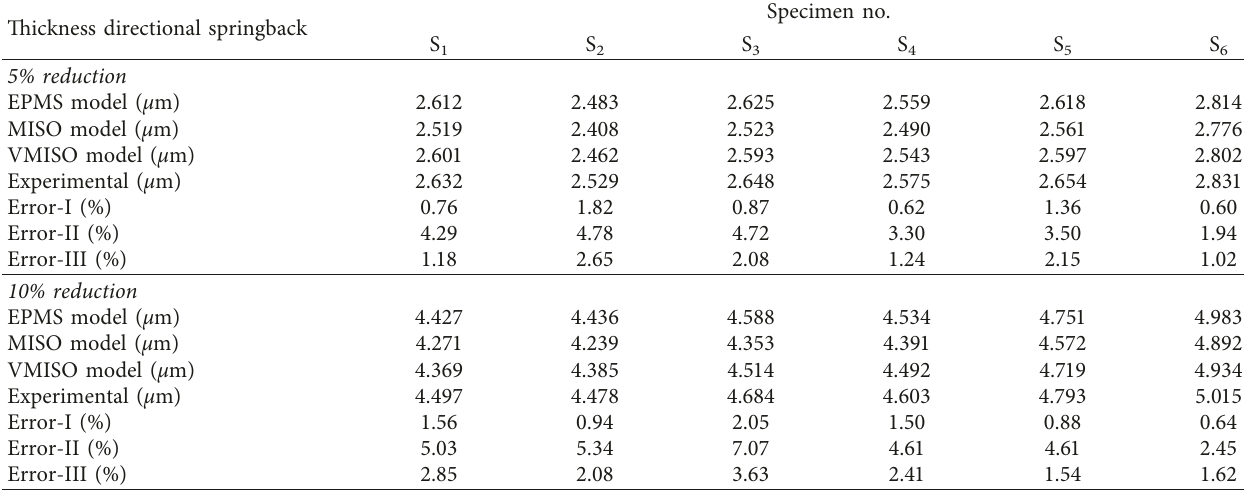
Figure 9: Correlation between thickness directional springback and average grain size for Groups S Table 4: Comparison between numerical results of thickness directional springback for 304 stainless steel specimens based on different constitutive/numerical models.